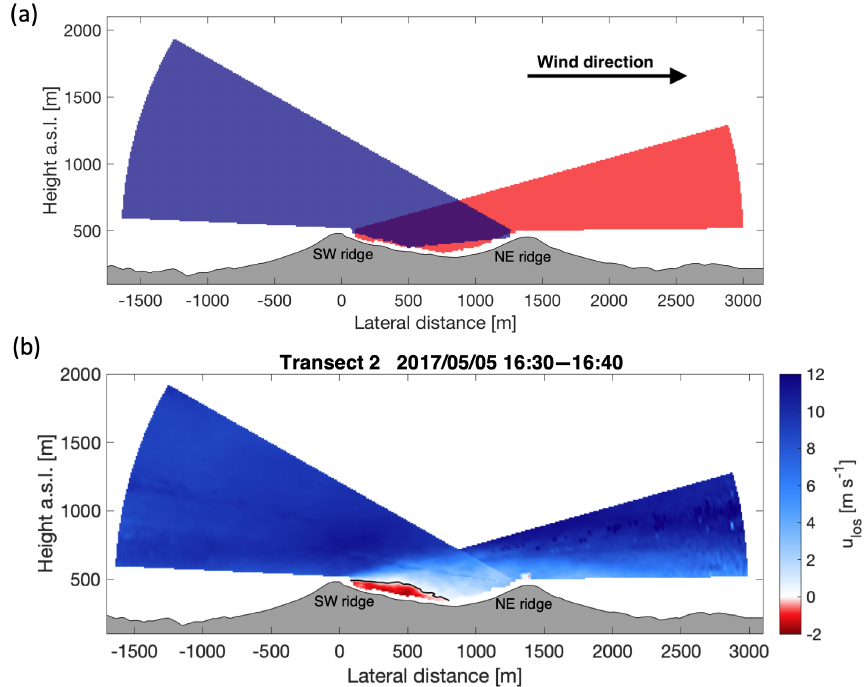
Figure 4. Detection of recirculation zones at the second transect (lateral distance of 0 is the position of WindScanner 102), view from the southeast. (a) Schematic of the overlay of the two RHI scans at the transect. Blue and red areas are corresponding to the RHI scans and the grey area shows the terrain. (b) Lidar measurements along the transect and detected recirculation zone for one 10min period with Ri G = 0 . 016. Positive LOS velocities indicate flow towards the northeast (from left to right in the plot). The terrain is plotted in grey and the contour line defining the recirculation zone is plotted in black inside the velocity field. Time is in